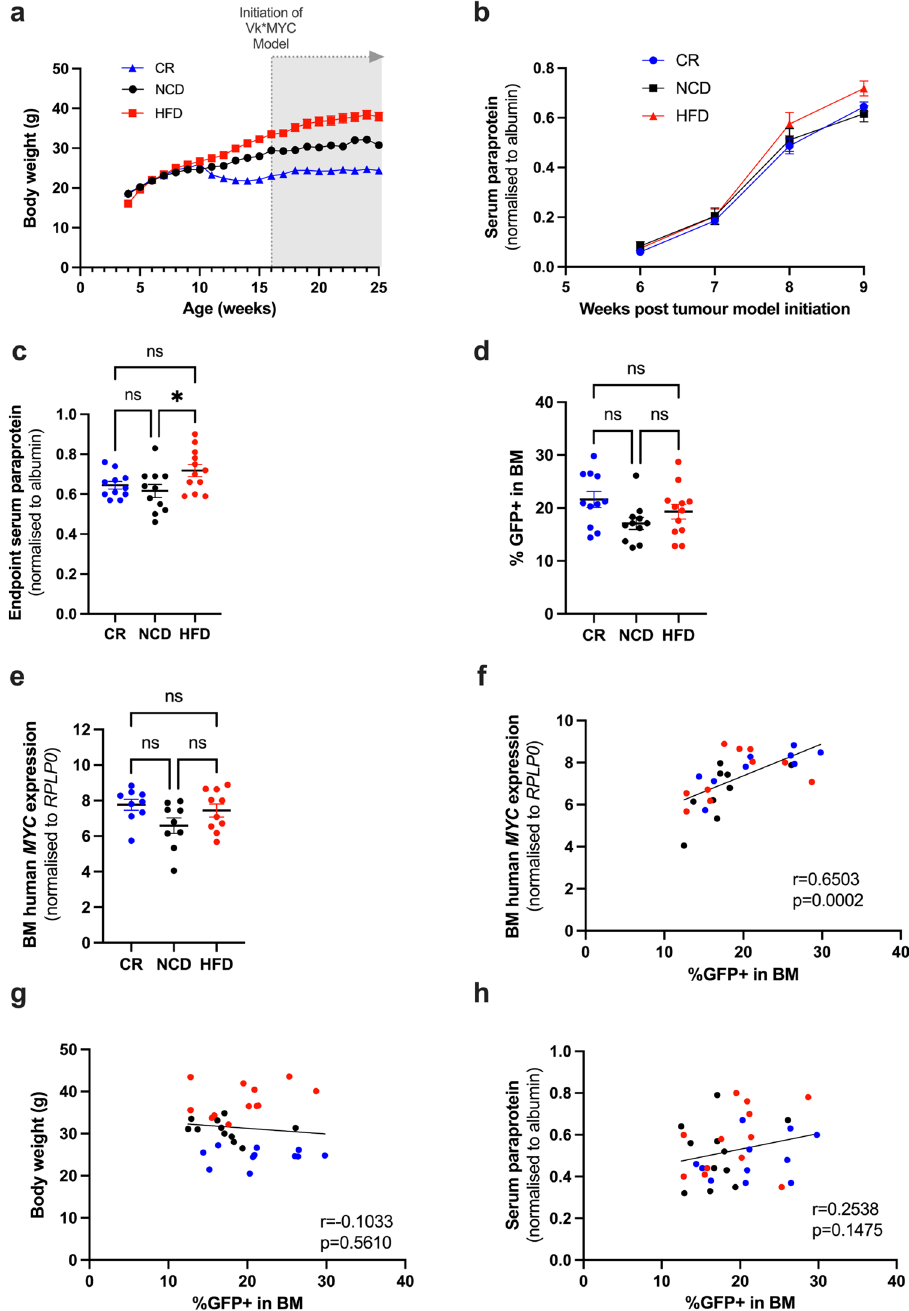
Figure 4. CR and HFD-feeding have no effect BM tumour burden. ( a ) Body weight over time, ( b ) Serum paraprotein levels over time, ( c ) Serum paraprotein levels at tumour endpoint (9 weeks post tumour initiation), ( d ) %GFP+ in the BM, ( e ) BM human MYC expression, ( f ) Correlation between %GFP+ in BM and BM human MYC expression, ( g ) Correlation between body weight and %GFP+ in BM, ( h ) Correlation between serum paraprotein and %GFP+ in BM. Error bars SEM, ( a – e ) n = 11–12 mice/group, ordinary one-way ANOVA with Tukey’s multiple comparisons test , ( f – h ) Combined data (n = 34 mice) from n = 11–12 mice/group, dot colours corresponds to diet group, blue dots: CR, black dots: NCD, red dots: HFD, correlation analysis, ns p > 0.05, *p < 0.05, **p < 0.01, ***p < 0.001, ****p <